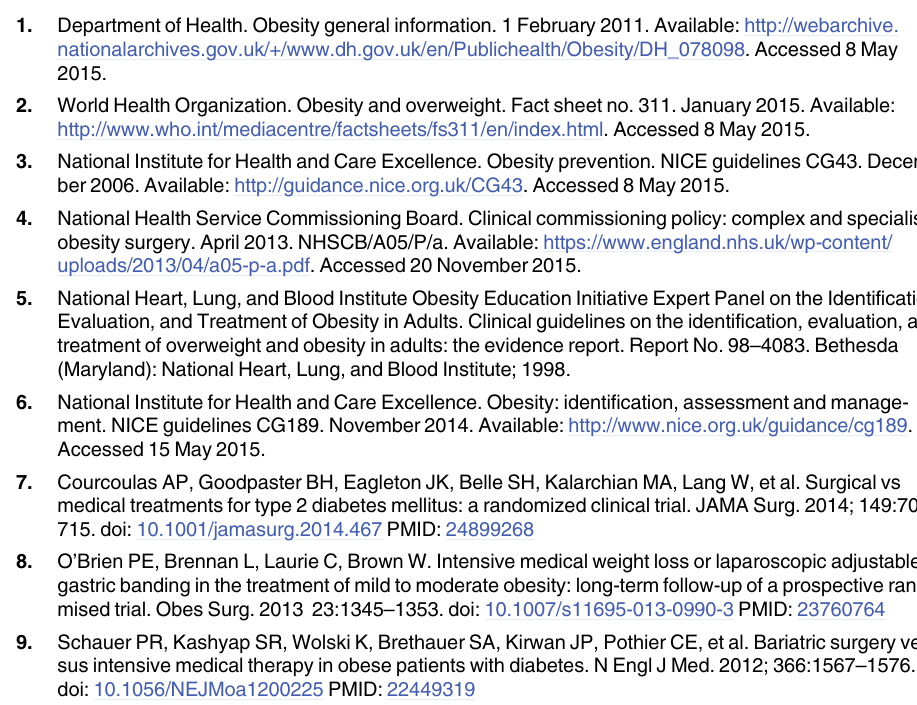
S2 Table. Association between bariatric surgery and health outcomes without trimming patients with extreme propensity scores. S3 Table. Association between bariatric surgery and health outcomes stratified by type of surgery, baseline type 2 diabetes, and baseline